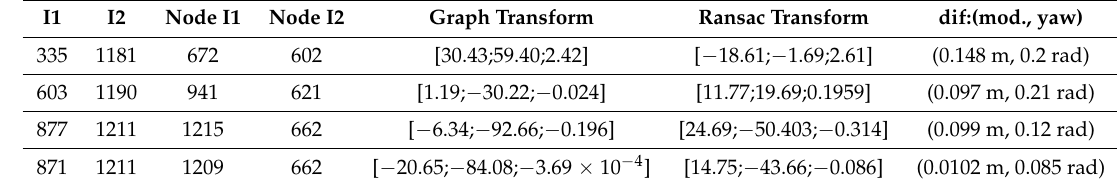
Table 2. Comparison of Transforms between images of S 21 and S